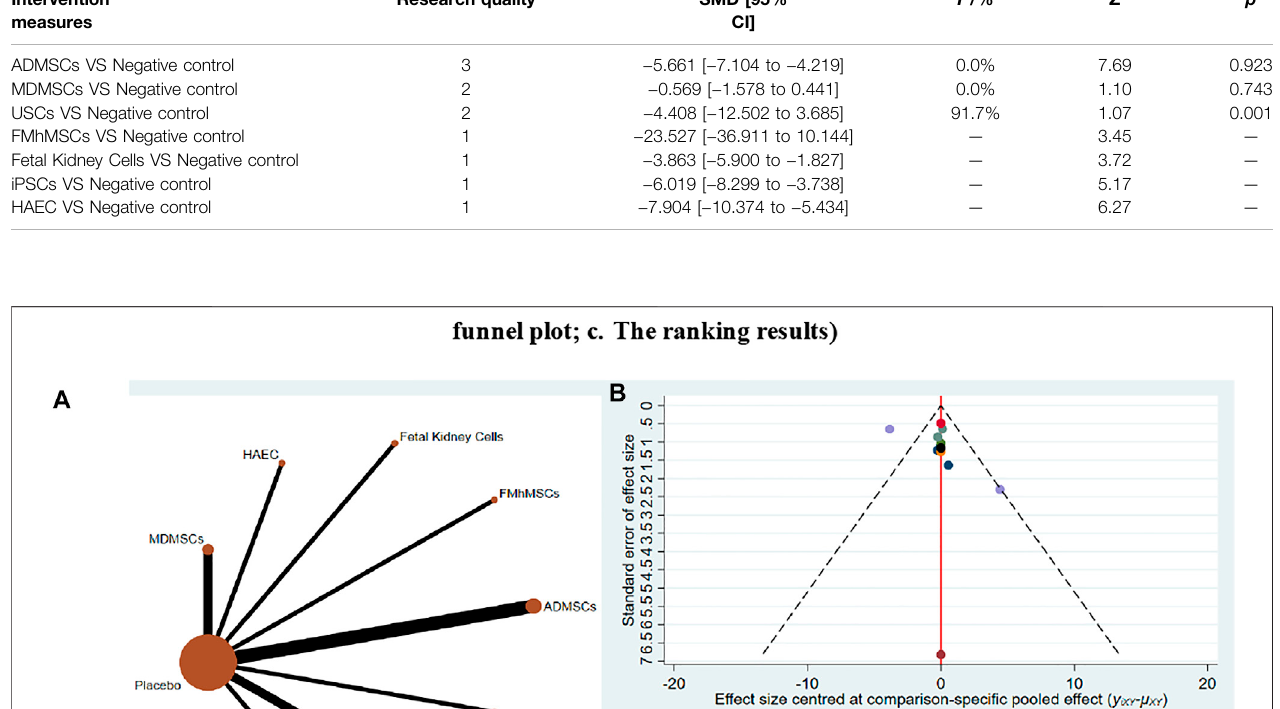
TABLE 17 | Traditional Meta-analysis results of apoptosis of resident cells between stem cell groups and the control group in early stage after administration. Intervention measures